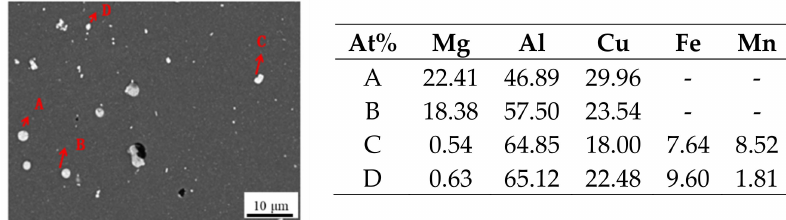
Figure 2. Coarse intermetallic particles in 2024 alloy and corresponding EDS